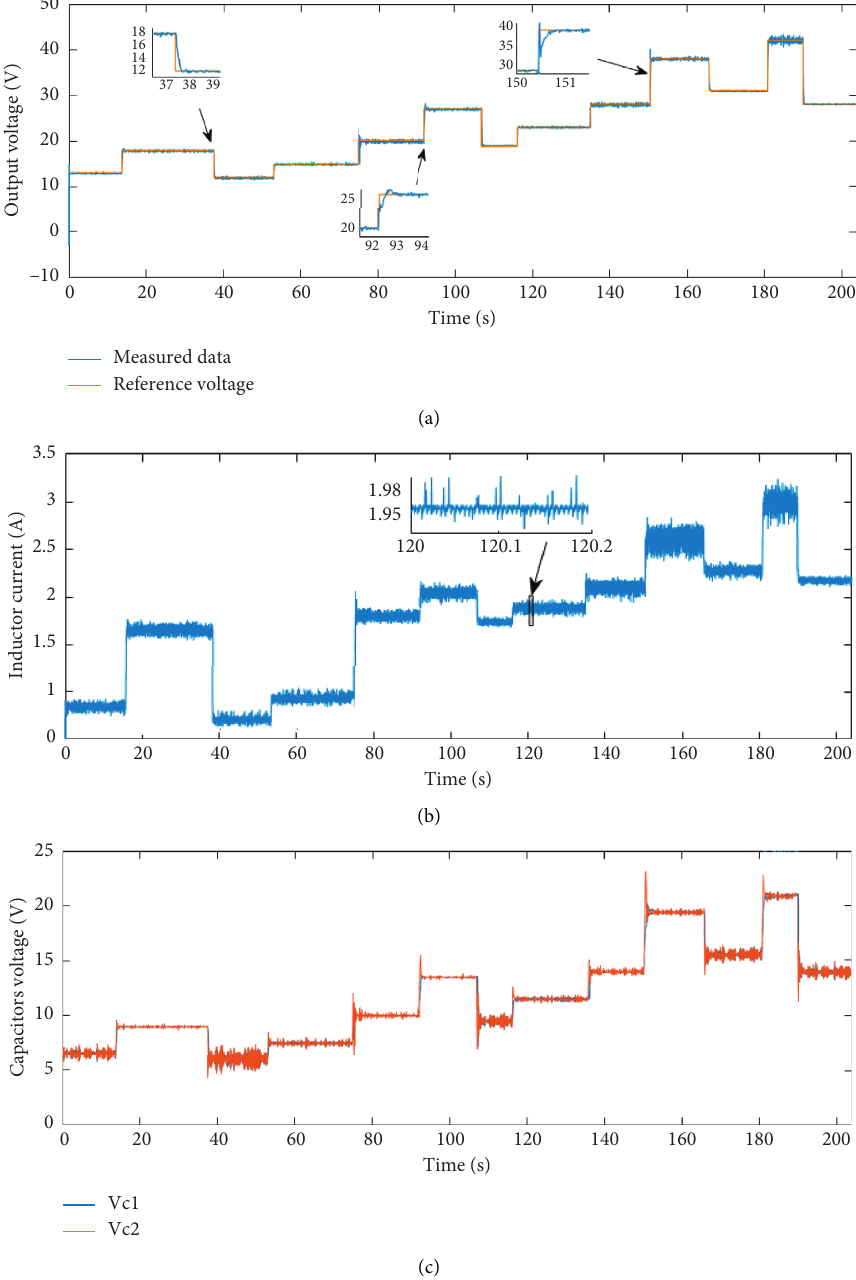
Figure 17: Experimental waveforms. (a) Output voltage. (b) Inductor current. (c) Vc 1 and Vc 2, resulted for reference voltage